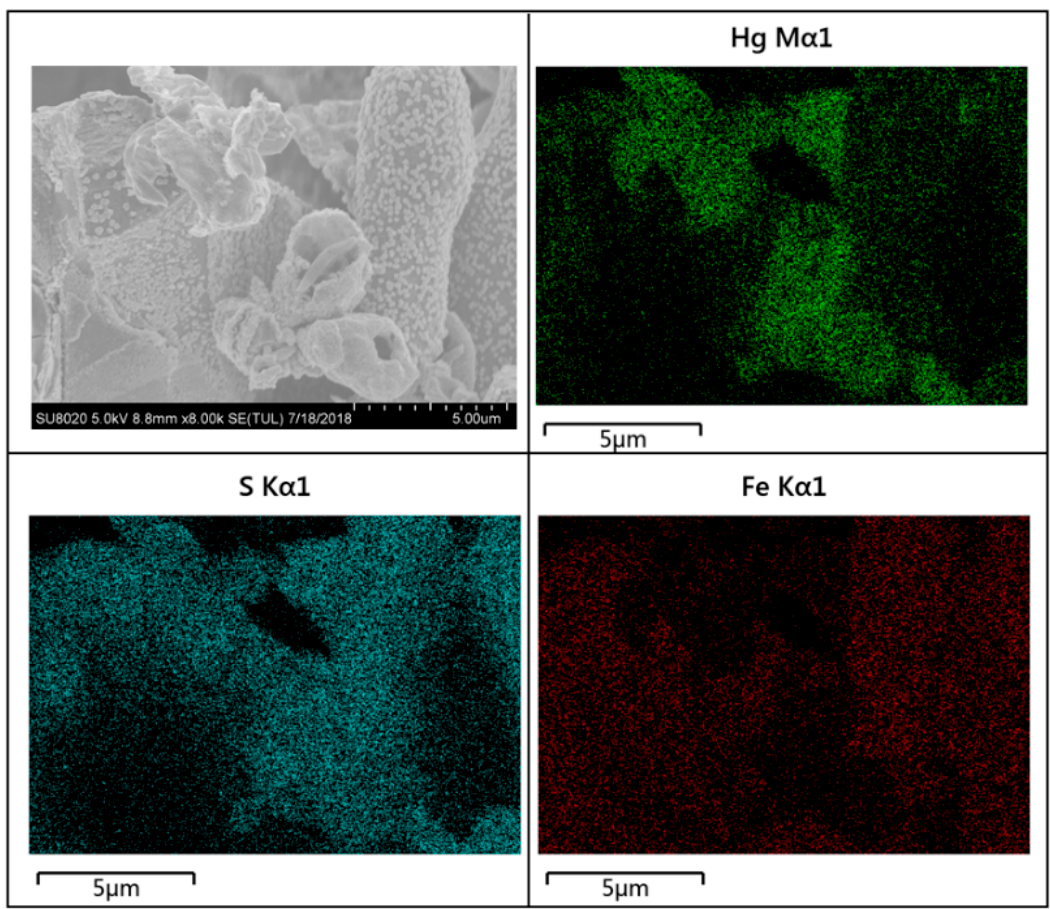
Figure 7. SEM images of the used MPy at the bottom of the column and corresponding EDX mapping images showing the Hg, Fe, and S distributions.